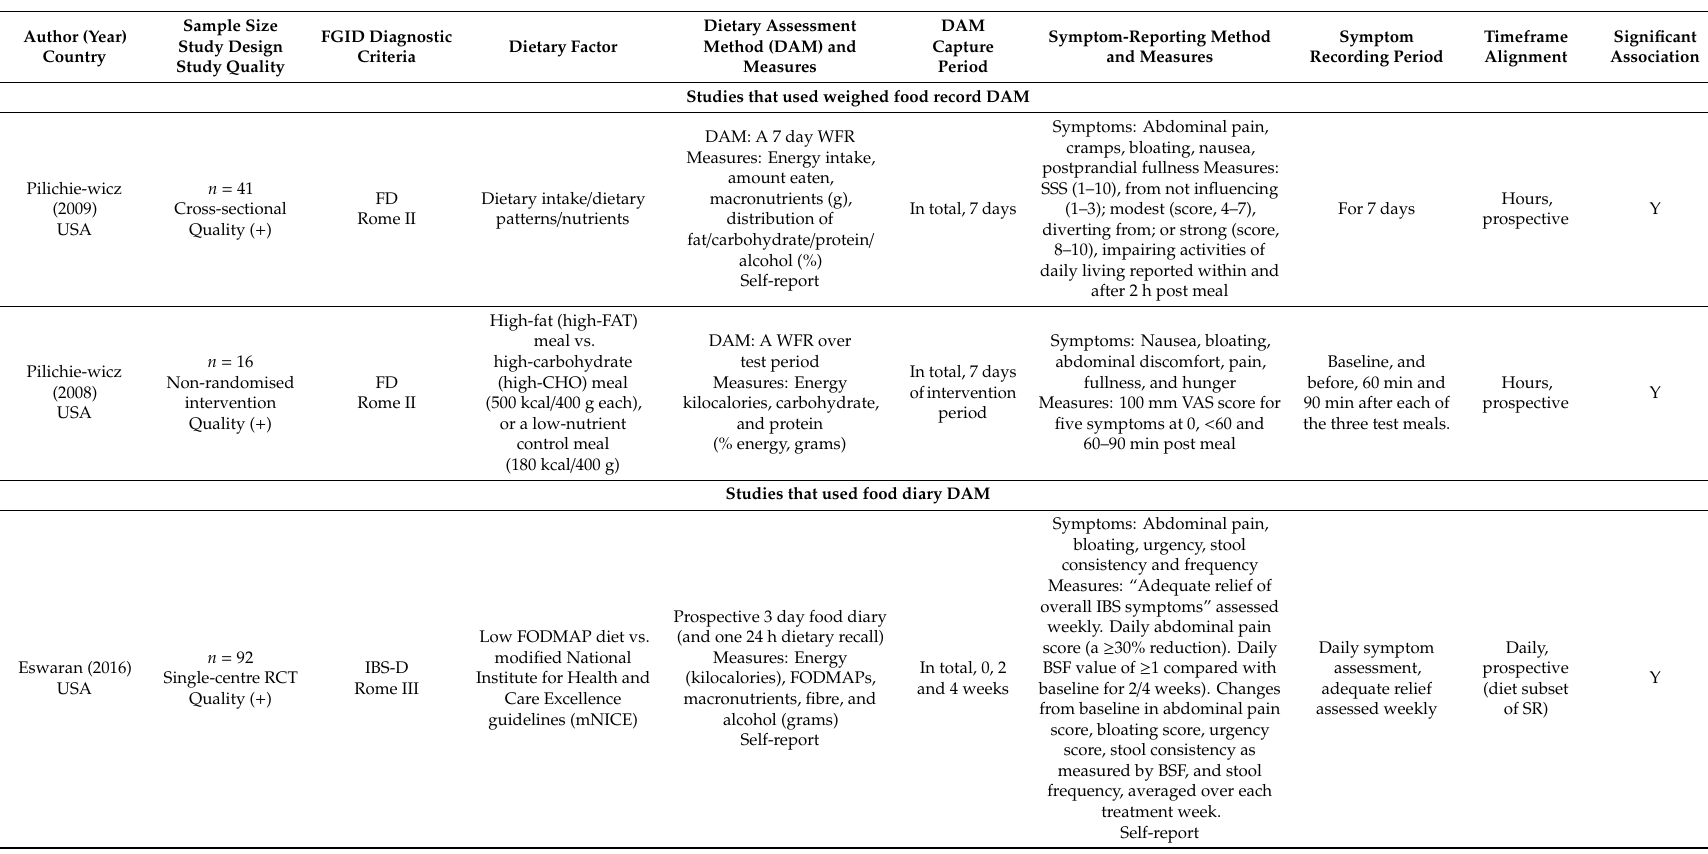
Table 2. Study characteristics, dietary assessment methods and measures, and symptoms assessment tools and measures for a scoping review of diet and symptom capture